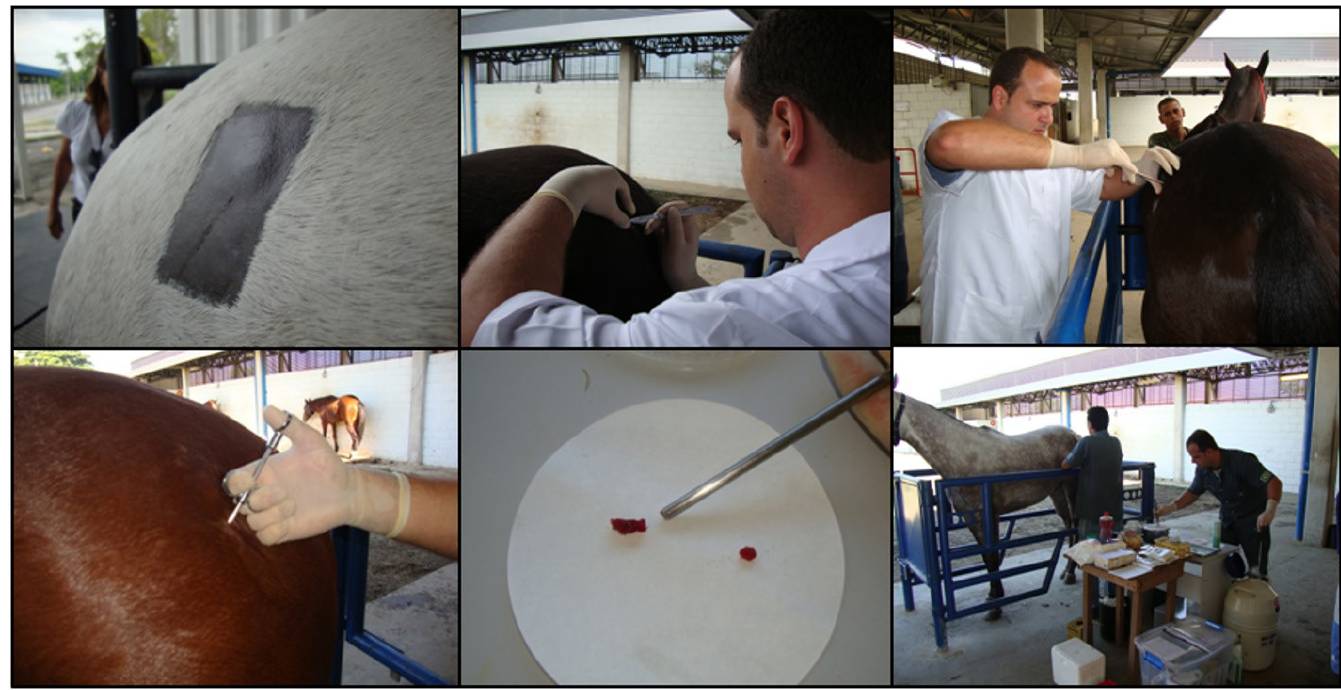
Figura 1. Sequência dos procedimentos da biópsia muscular percutânea do Glúteo Médio dos equinos: bloqueio local; incisão da pele e tecido subcutâneo; introdução da agulha de biópsia; abertura da janela de corte a 6 cm de profundidade; pré-secagem do material obtido, utilizando-se o papel filtro; identificação e congelamento das